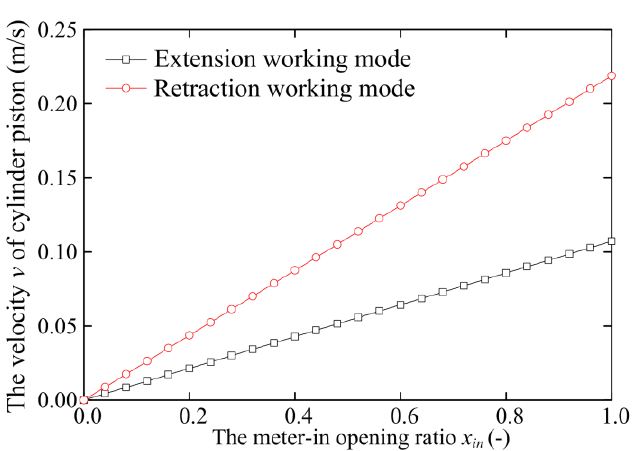
Figure 26. The variations of the flow rate Q b of the cylinder rod chamber of HPCIMS.